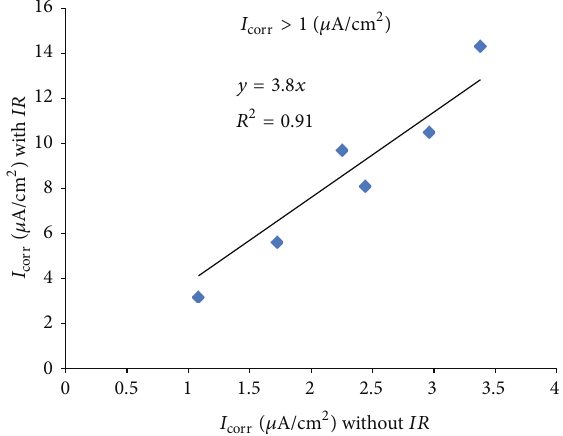
Figure 12: Correlation between 𝐼 > 1 𝜇 A/cm 2 . sation for 𝐼 corr